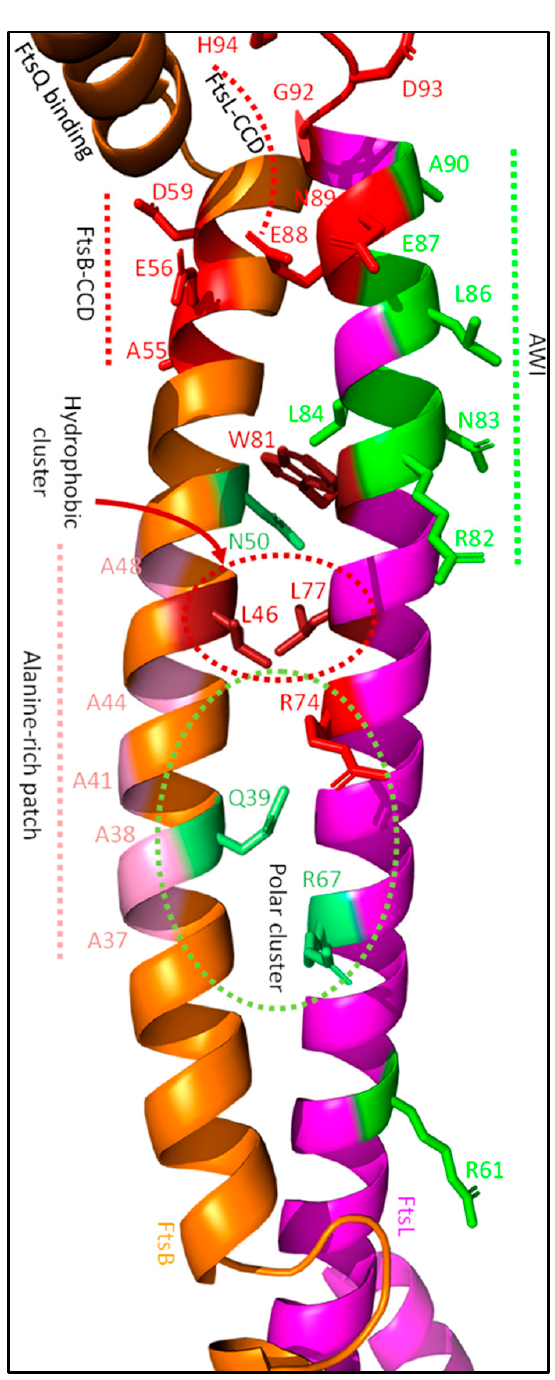
Figure 13. FtsBL coiled coil stability. Modulating the stability of the FtsBL coiled coil structure is an integral part of sPG synthesis regulation. The stability is dynamically affected by polar (Q39, R67, R74; N50) and hydrophobic (L46, L77, W81) clusters located at the inner part of the coiled coil between the transmembrane and the CCD/AWI domains. FtsB contains an alanine-rich patch at the other face of the helix, forming a dimerization/intercoil domain. The CCD (red) and AWI (green) domains just upstream are involved in the suppression and activation of sPG synthesis, respectively. Just above the FtsB CCD domain, a region stably interacting with FtsQ can be